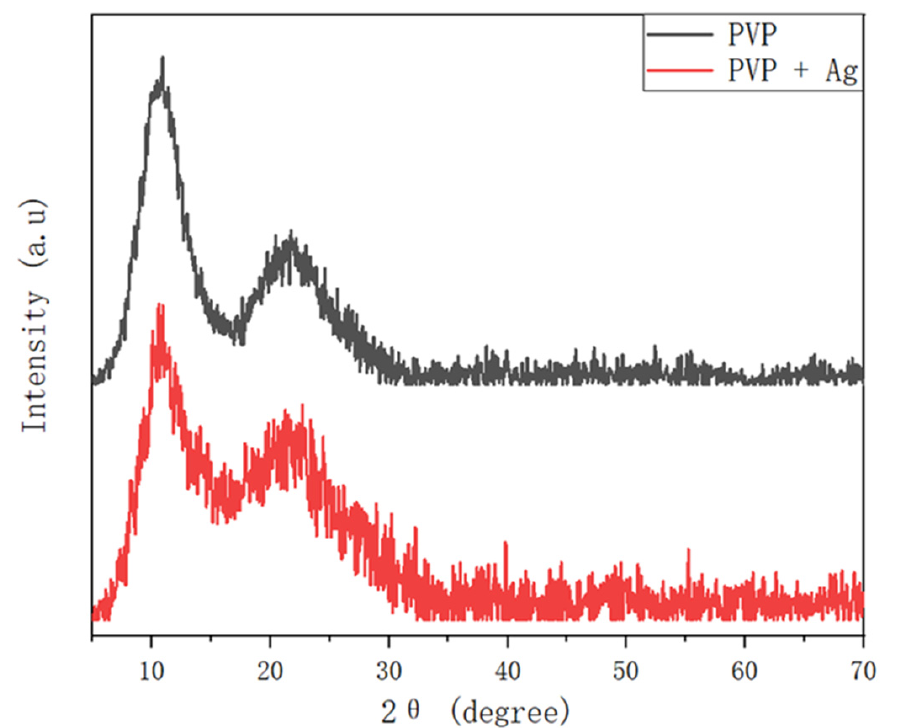
Figure 10. XRD pattern of the pure PVP fibers and of the PVP/Ag NP composite fibers electrospun at 5 MPa at an applied voltage of 15 kV.